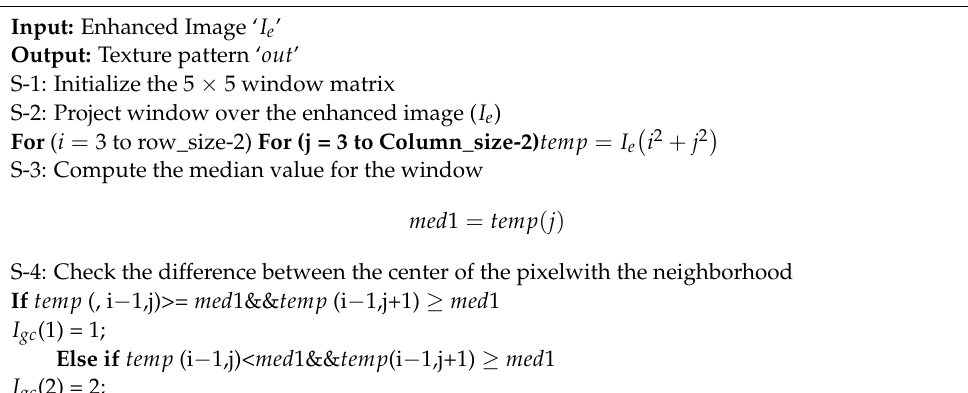
Algorithm 1. Extended Differential